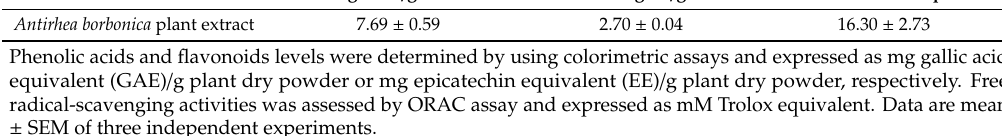
Table2. Totalpolyphenol, flavonoidcontentandantioxidantactivityof Antirheaborbonica plantsextracts. Total Polyphenol Content Total Flavonoid Radical Scavenging Capacity (mg GAE / g Plant) Content (mg EE / g Plant) (mM Trolox eq.) 7.69 ± 0.59 2.70 ± 0.04 16.30 ±